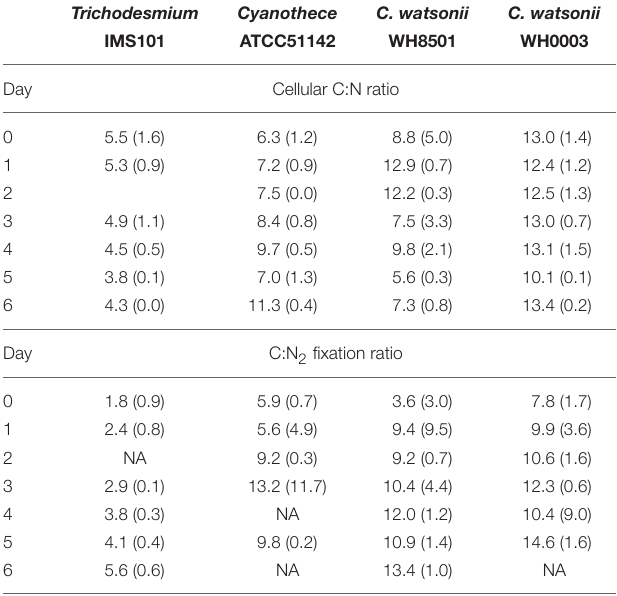
TABLE 2 | Cellular C:N ratios and net C:N 2 fixation ratios along the 6 days of exp 1. Trichodesmium